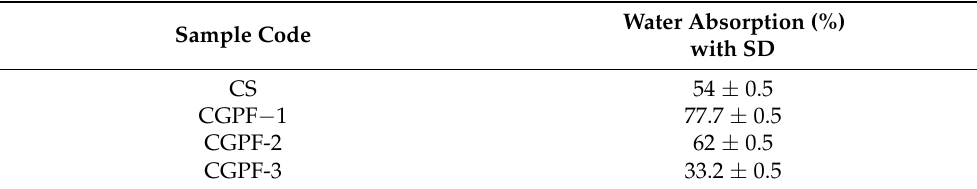
Table 2. Water retention behavior of nanocomposite